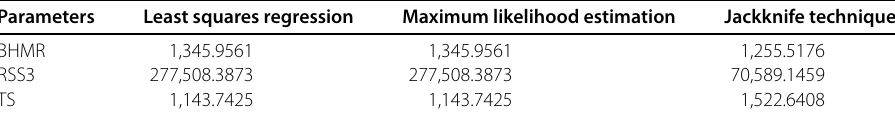
Table 5 Sum squared error Parameters Least squares regression Maximum likelihood estimation Jackknife technique